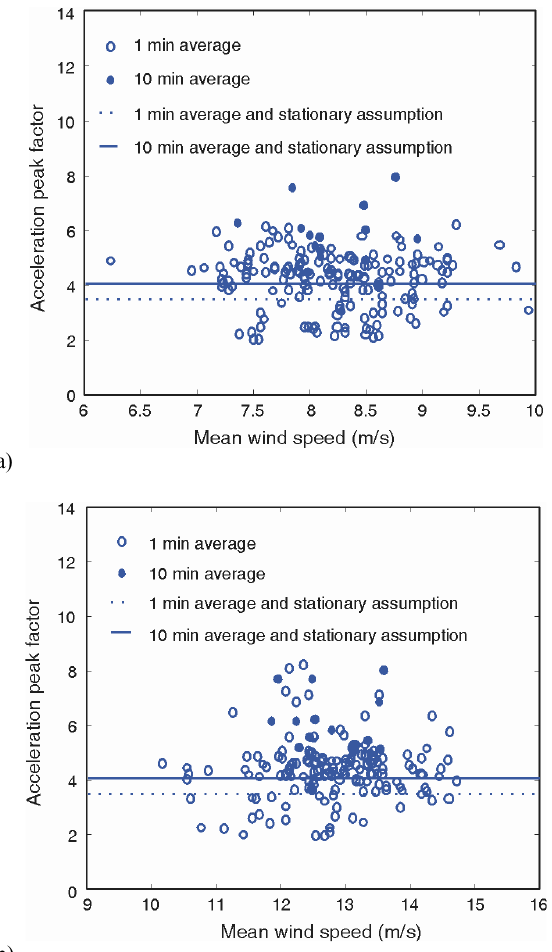
Fig. 6. Relation between in-plane acceleration peak factors and the mean wind speed: (a) deck level wind speed (16:51–21:36, 1 April 2003); (b) tower top wind speed (16:51–21:36, 1 April